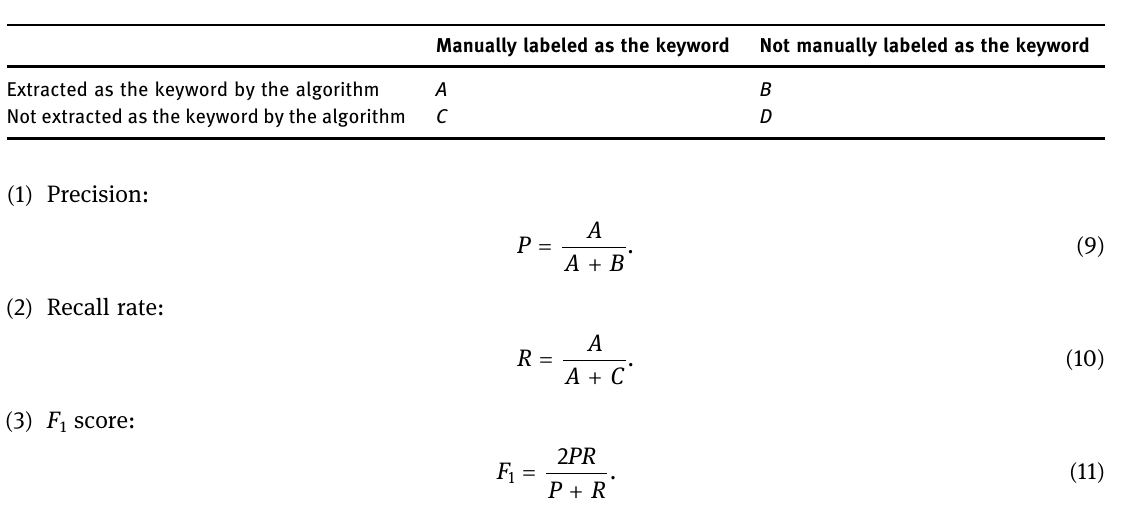
Table 3: Results of keyword